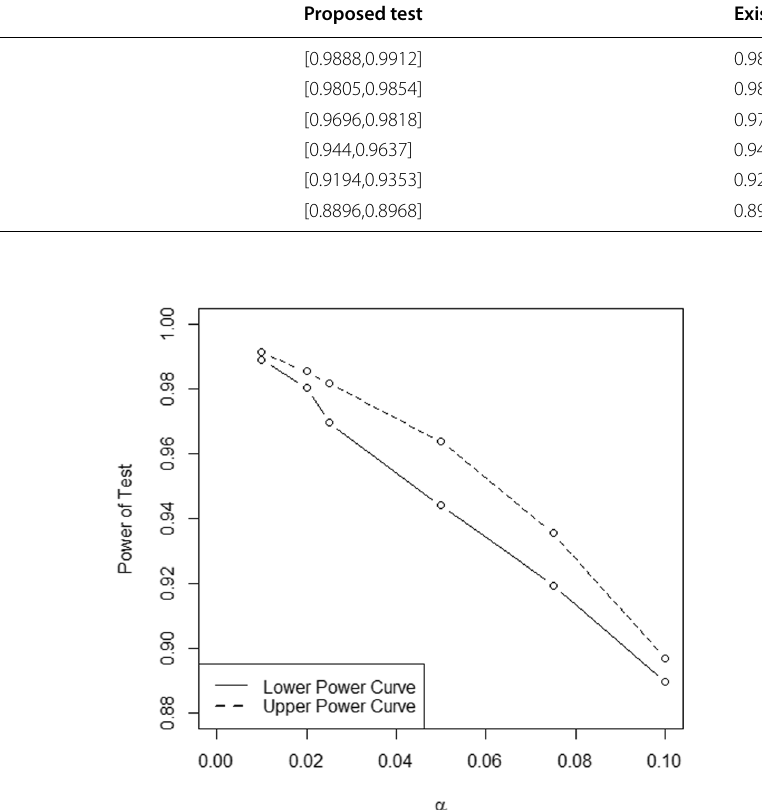
Fig. 1 The power curves of